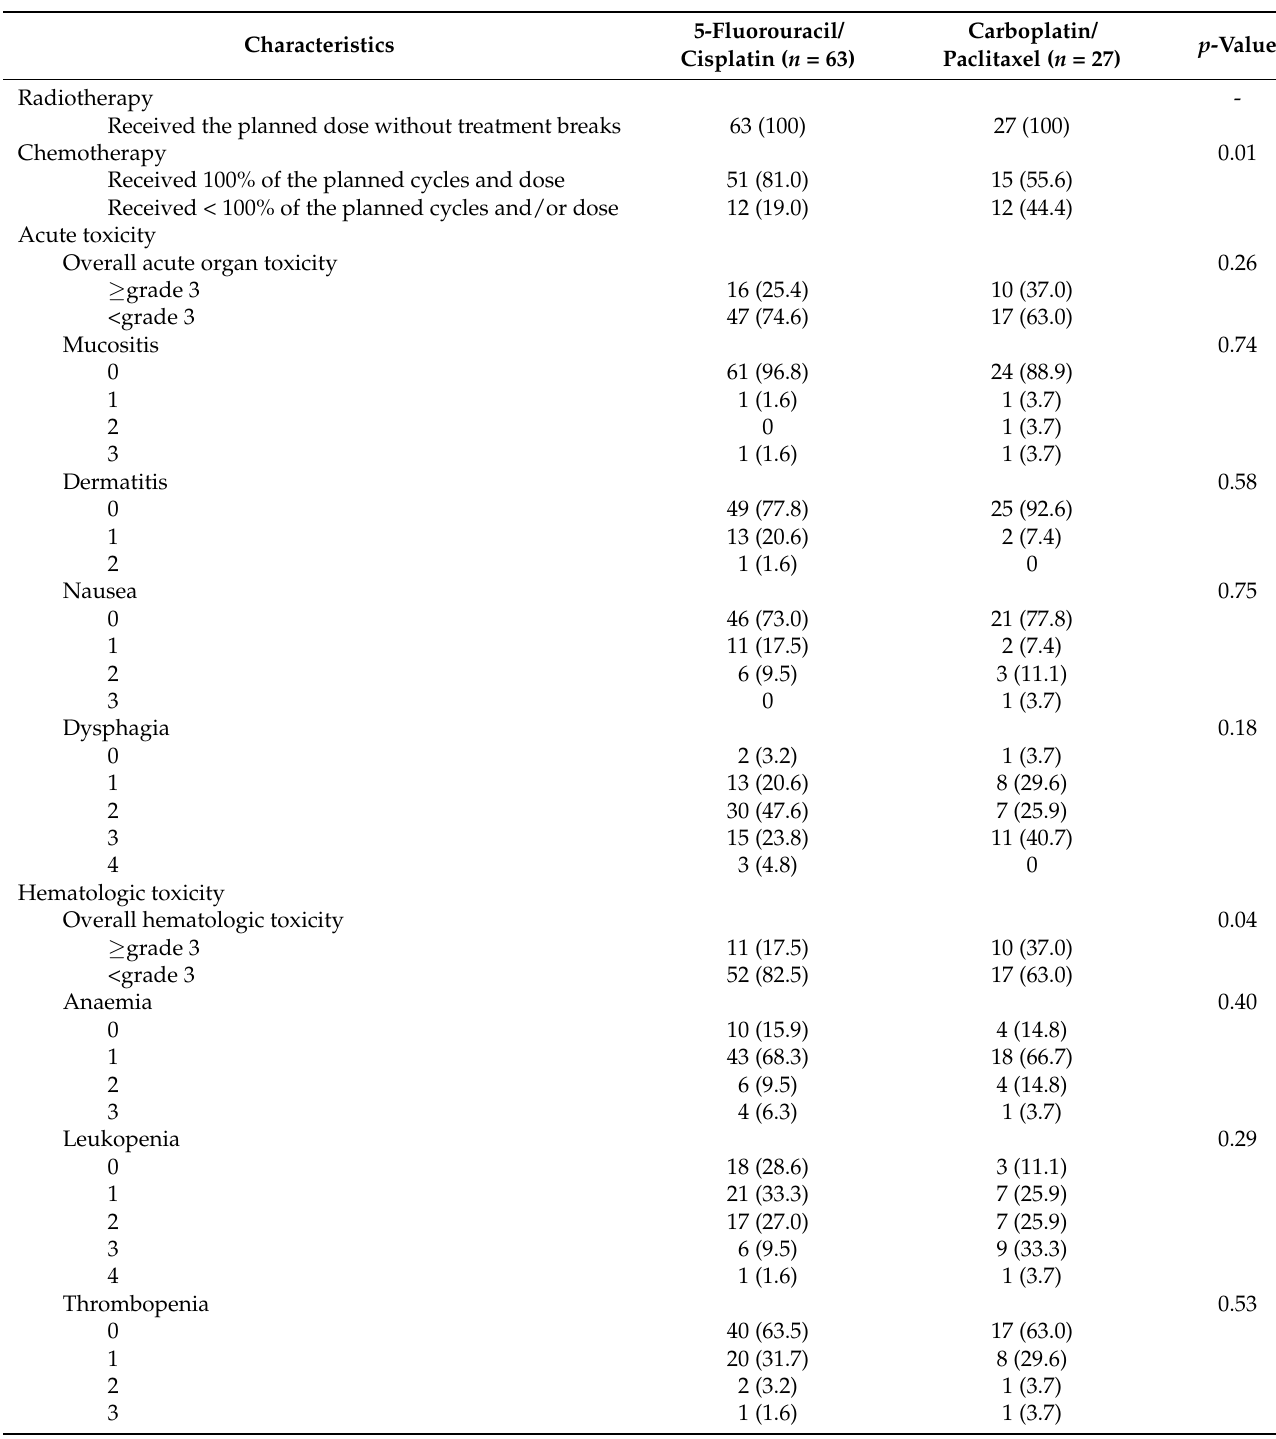
Table 2. Radiochemotherapy: Treatment completion rates and acute toxicity. For each parameter, the number of patients and, in brackets, the percentage are given. The statistical comparisons were performed with Chi-square test and Kruskal– Wallis